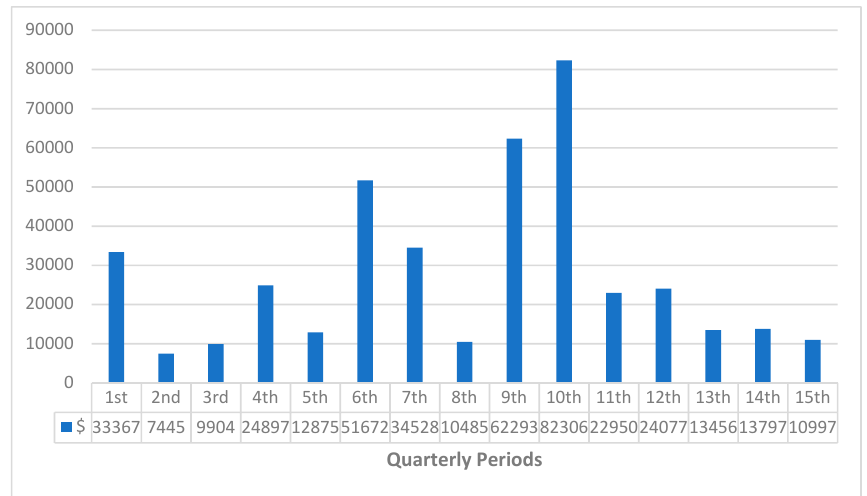
Figure 12. Loss in the cost of product not produced across the observed quarterly periods for ware transfer mechanism.